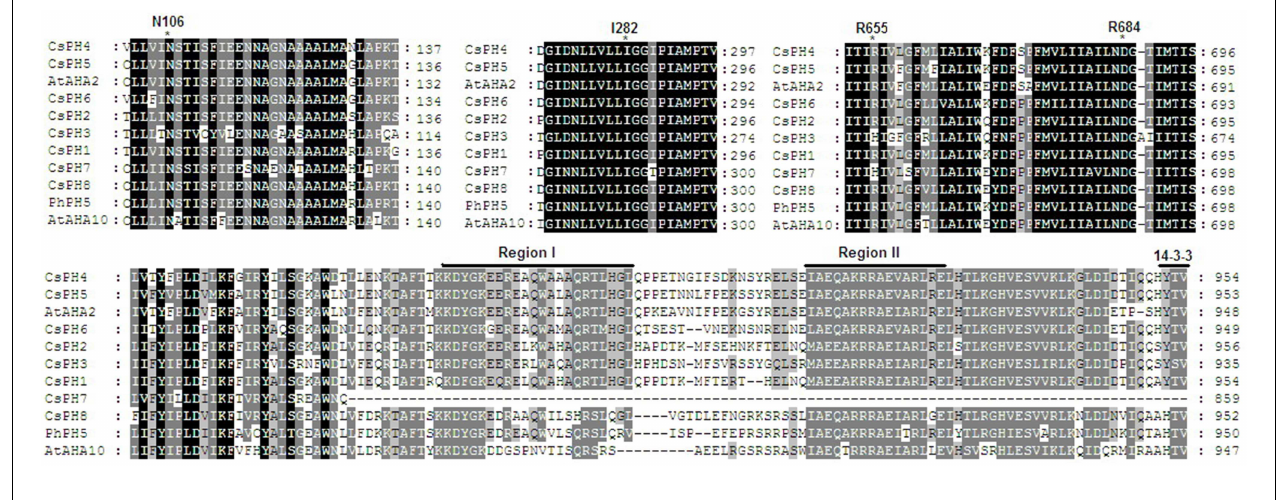
analysis of an AtAHA2 crystal structure (Pedersen et al., 2007). The number of amino acid residues in AtAHA2 is indicated above each asterisk. R655 seems important for controlling the back flow of H + at high electro-chemical gradients (Pedersen et al., 2007). The two putative autoinhibitory sequences, RegionI and RegionII, were identified by Axelsen et al. (1999), and a 14-3-3 binding site (Fuglsang et al., 1999) is shown in the C-terminal region.